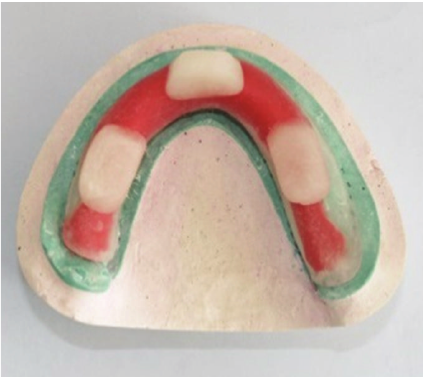
Figure 11: Mandibular custom tray with wax spacer removed. Multiple relief holes are placed in areas of flabby tissue.